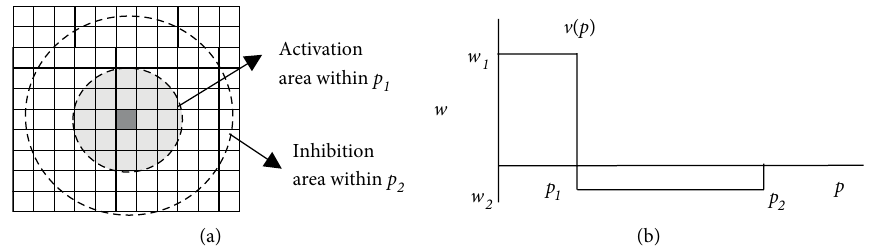
Figure 1: Examples of Turing patterns using Young’s model. Outline of Young’s model. (a) The activation area has a radius 𝑝 . (b) The function v (𝑝) is a continuous step function representing the activation area and the inhibition area has an outer radius 𝑝 2